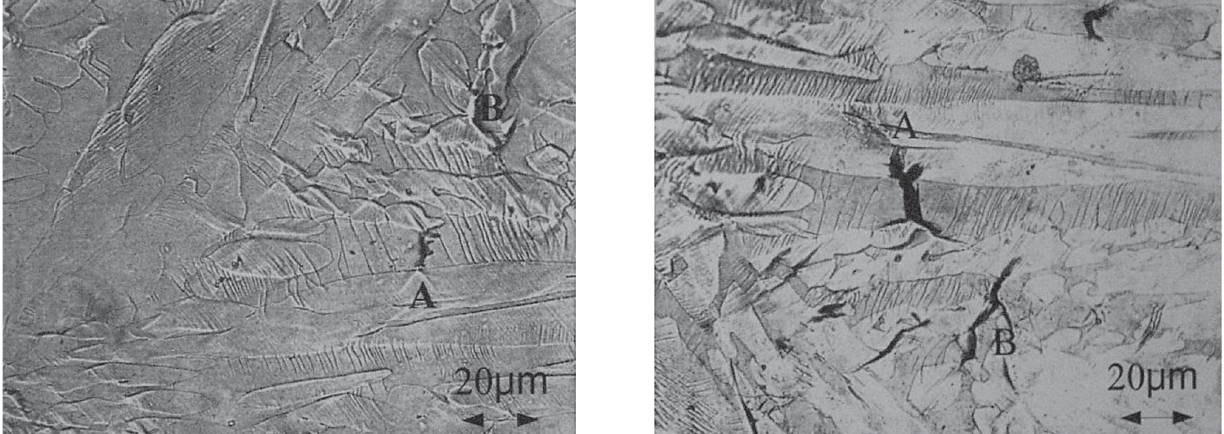
Figure 3. Damage progression. Left photograph shows a replica taken at 6% of plastic deformation. Right photograph shows the same region on the specimen after rupture (12% deformation). A and B indicates the same crack on the two